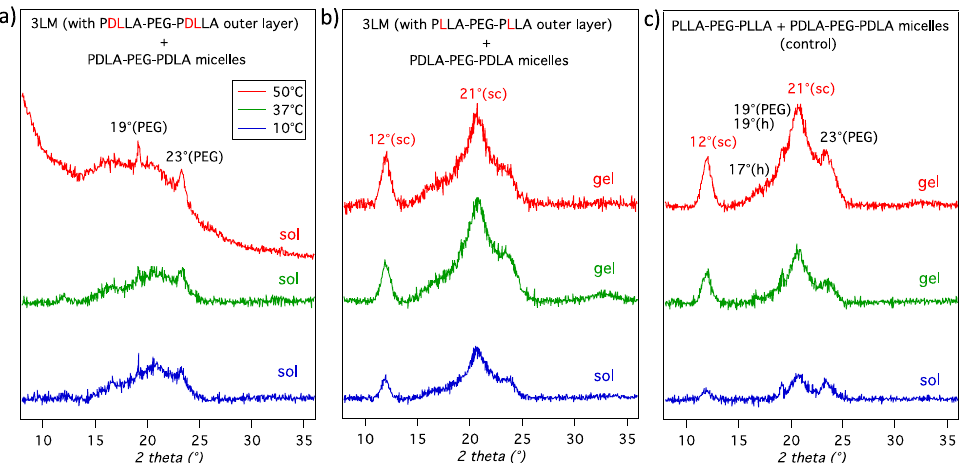
Figure 3. WAXD profiles of hydrogels prepared mixing the following micelles with PDLA-PEG-PDLA micelles: (a) 3LM using PDLLA-PEG-PDLLA (racemic polymer) outer layer; (b) typical 3LM from PLLA-PEG-PLLA outer layer; and (c) simple PLLA-PEG-PLLA micelles. The phase transition (sol-to-gel) diagrams for the different formulations are shown in Figure 4. The phase diagram of 3LM with the 1:1 inner:outer ratio mixed with D-micelle (Figure 4a) shows a linear decrease in the sol-gel transition temperature with increasing polymer concentration.